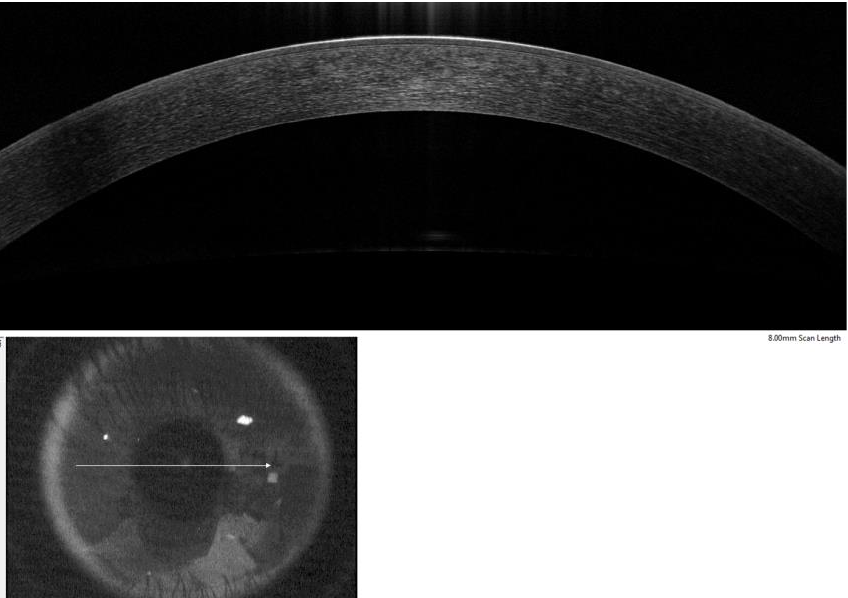
Figure 5. An optical coherence tomography image of the central cornea shows that the epithelial thickness of the central corneal epithelium is more uniform than that of the limbal epithelium.